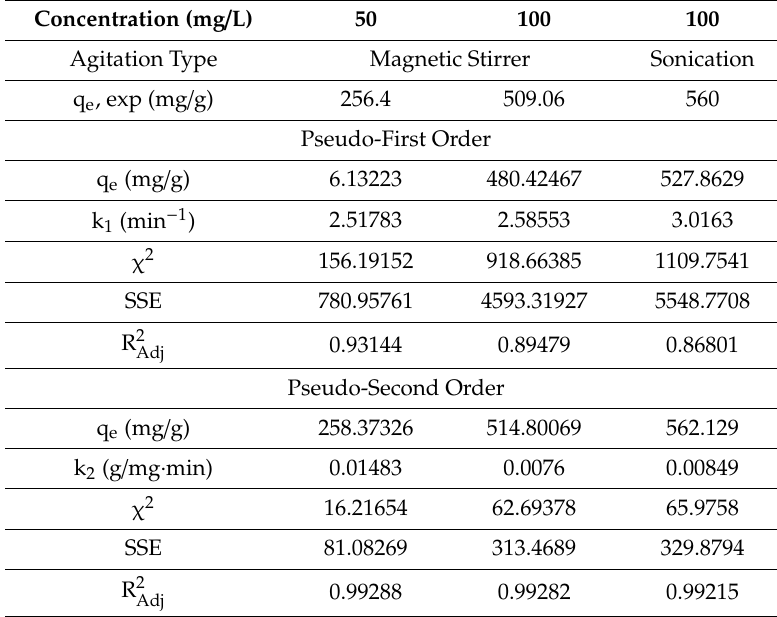
Figure 6. Nonlinear plots of kinetic models used for adsorption of CIP ( a ) 50 mg/L, ( b ) 100 mg/ L, ( c ) 100 mg/L sonication. Table 8. Kinetic values of CIP adsorption onto